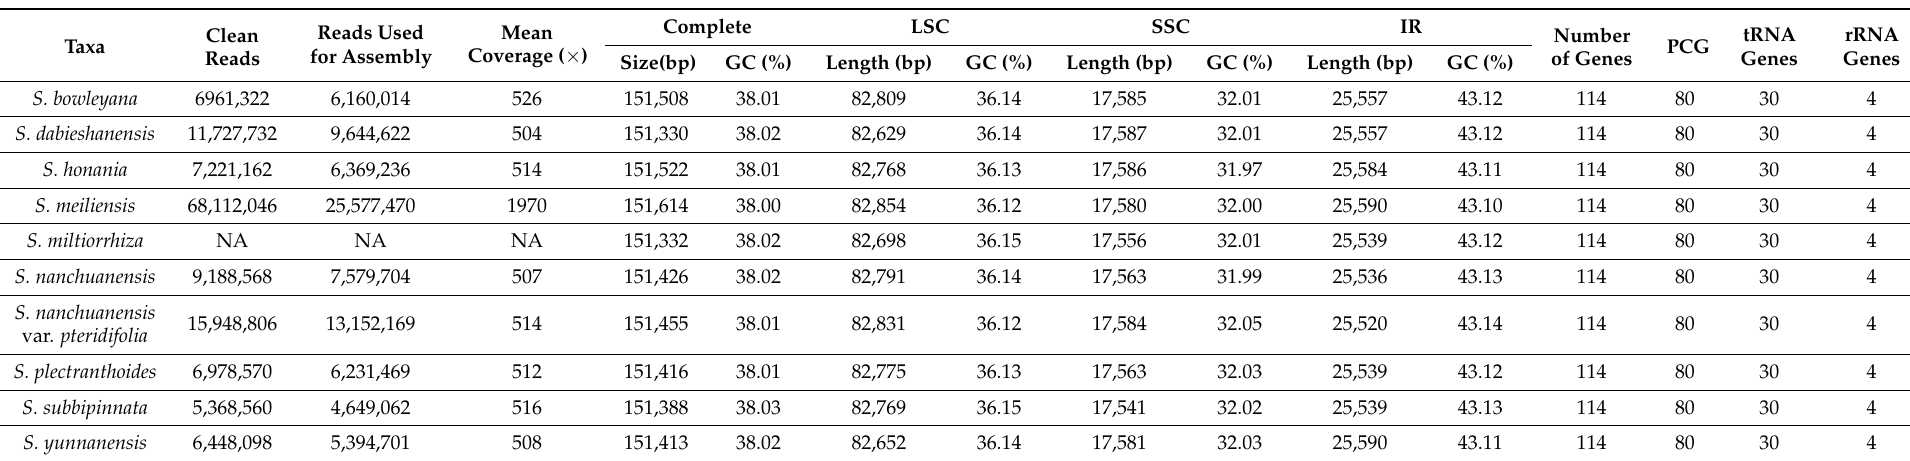
Table 3. Plastome features of 10 taxa of Salvia sect. Drymosphace presented in this